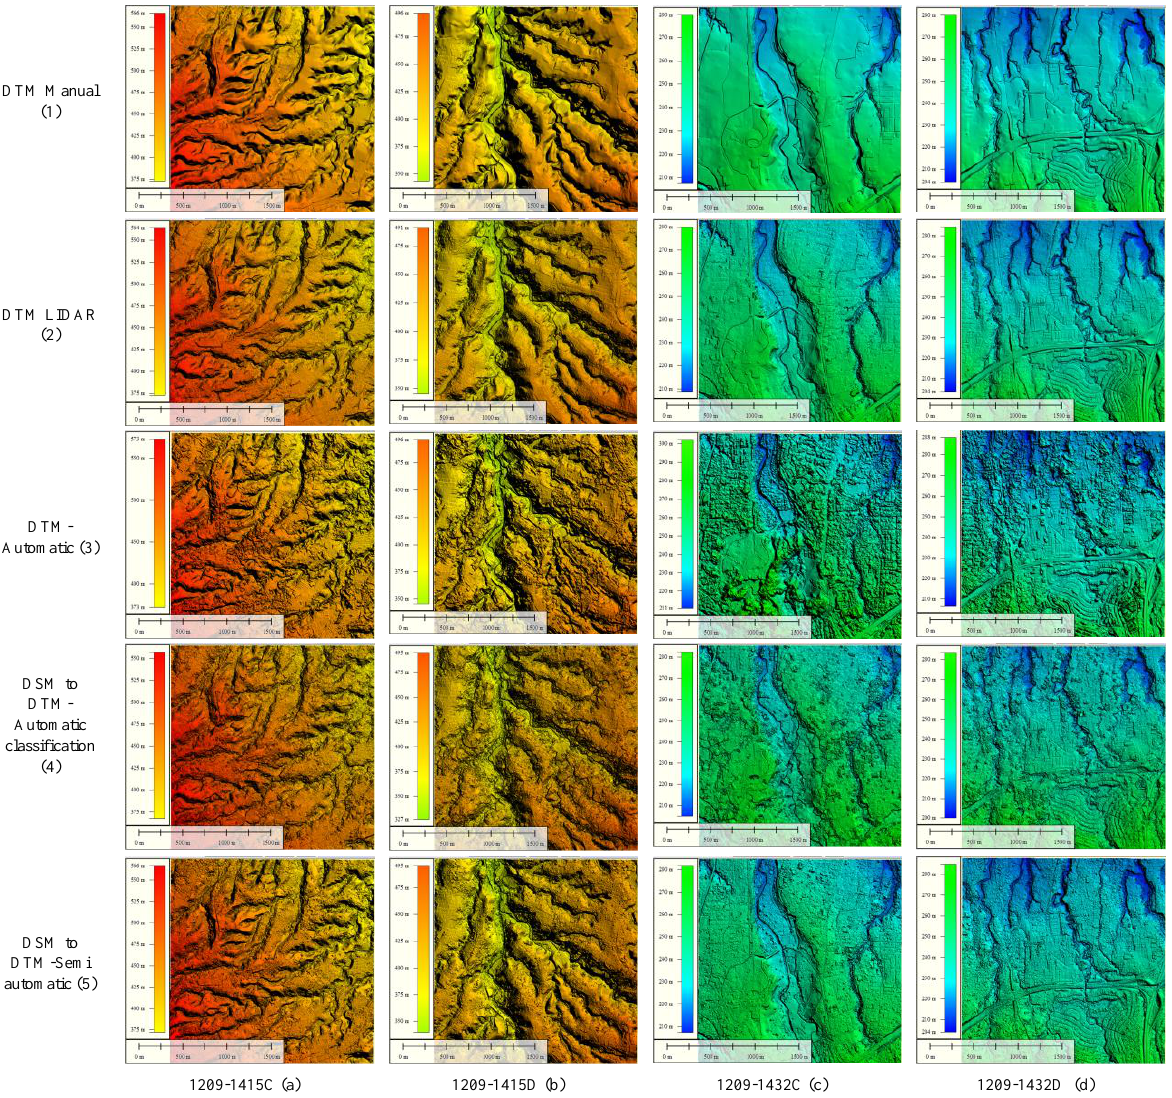
Figure 6. Geomorphological quality comparison of each method from forestry area with mountainous terrain (a) (b), and urban area with flat terrain (c) (d) Manual stereoplotting data have top and ground measured point with irregular grid point, it is about 2-20 m interval